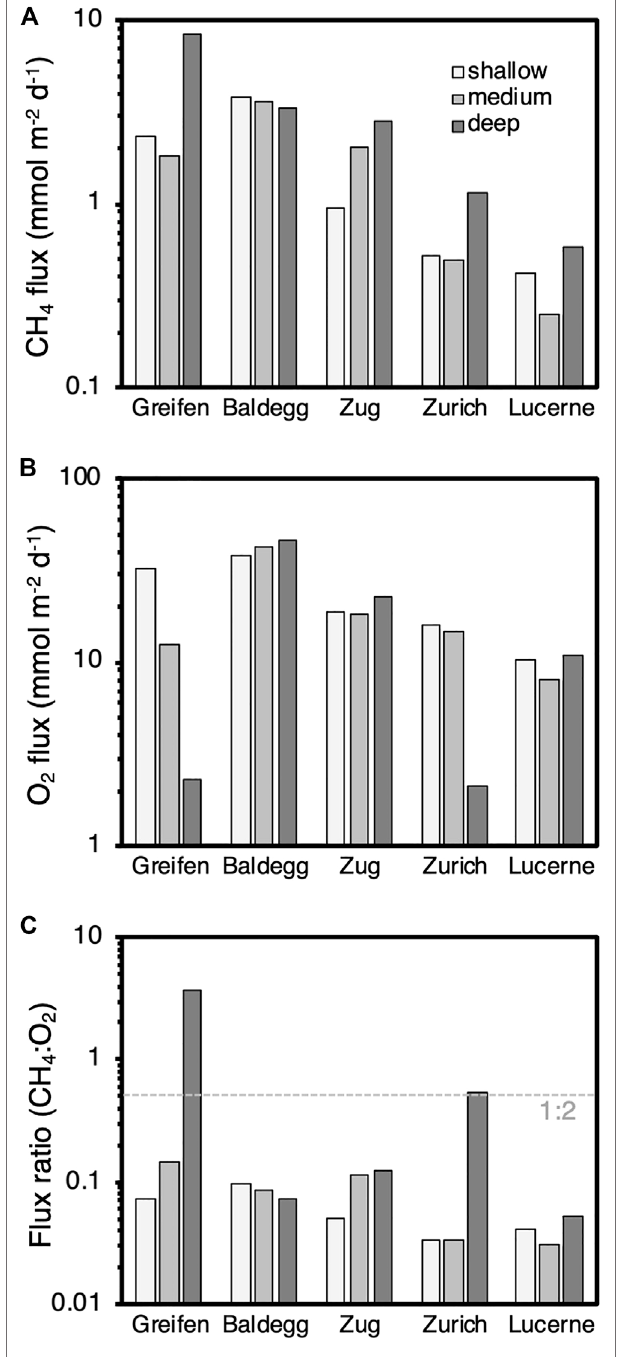
FIGURE 2 | Modeled diffusive fl uxes of (A) methane and (B) O 2 , and (C) diffusive fl ux ratios (CH 4 :O 2 ) for all lake stations. The dashed line in (C) indicates a 1:2 fl ux ratio of CH 4 to O 2 . Values below this value indicate a suf fi ciently high O 2 fl ux for the complete oxidation of all upward diffusing CH 4 tobicarbonate(HCO 3 − ).Valuesabovethisdashedline(onlydeephypoxic stations of Lake Greifen and Lake Zurich) indicate insuf fi cient O 2 in fl ux to oxidize all CH 4 to